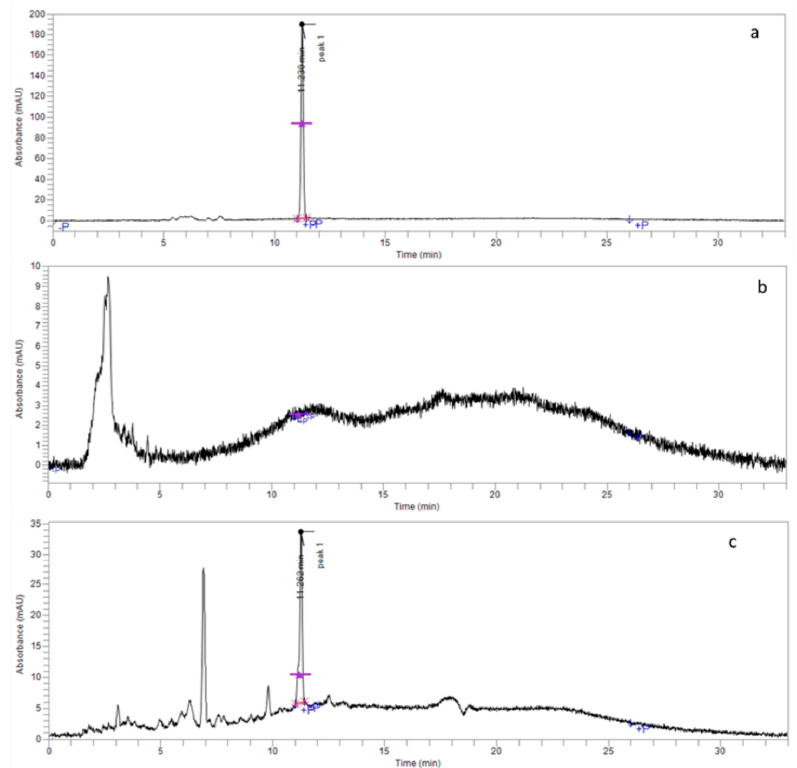
4-NC Encapsulation e ffi ciency in nanoparticles. ( a ) 4-NC Chromatographic profile. ( b ) Chromatographic profile of 4-NC Nanoparticles filtered in Amicon ® tube. ( c ) Chromatographic profile of 4-NC nanoparticles retained in the Amicon ® tube.